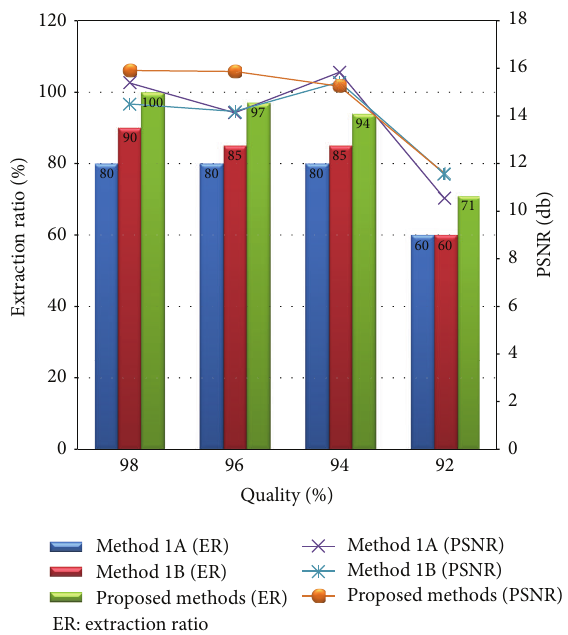
Figure 13: Extraction ratio and PSNR in each quality.